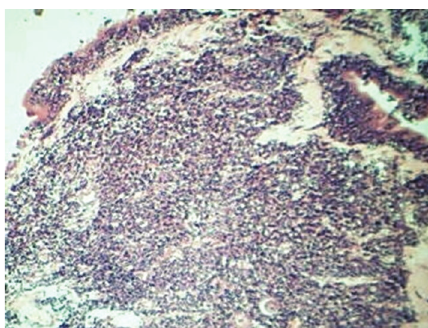
Figure 2: (haematoxylin and eosin × 100): Showing poorly differen- tiated malignant neoplasm with neuroendocrine differentiation.